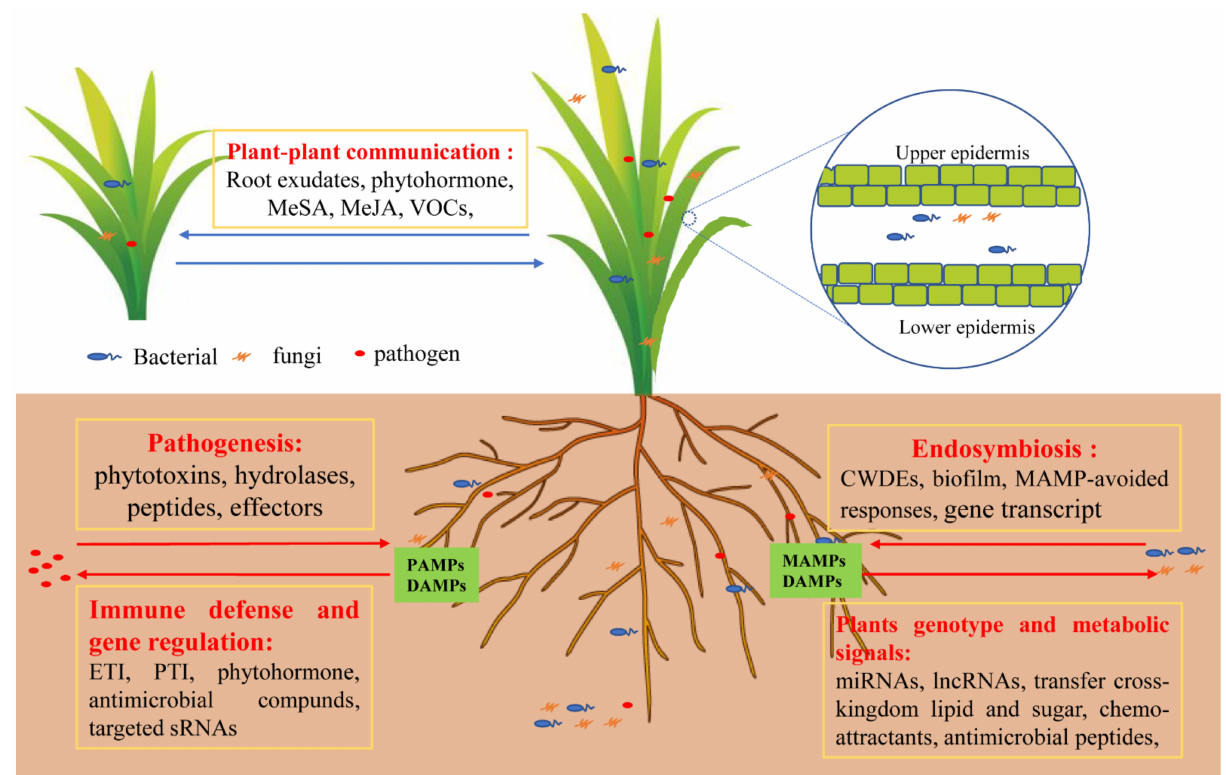
Figure 3. Immunity and symbiotic regulation of plants to microorganisms. Pathogens secrete phytotoxins, hydrolases, peptides, and other effectors. Plants activate the immune defense signaling response, such as ETI and PTI, and secrete phytohormones, antimicrobial compounds, or target sRNAs via gene regulation. Certain types of bacteria and fungi termed endophytes are allowed to enter plant cells by secreting biofilm or by using hyphae to attach to plant tissues and secrete CWDEs to degrade plant cell walls. Moreover, it can regulate gene transcription through evolution to escape plant immune signals and produce symbiotic signals as well as collectively resist pathogen attacks. Accordingly, plants secrete chemo-attractants to attract beneficial endosymbiotic microbes, evolve their own genotype, and transfer cross- kingdom lipid and sugar to endophytes, providing a good parasitic environment for endophytes. Hence, a plant’s genotype can influence the microbiome composition and shape their microbiome to enhance defense and mitigate the trade-off between growth and defense against pathogens. Abbreviations: cell wall degradative enzymes (CWDEs), methylsalicylic acid (MeSA), methyljasmonic acid (MeJA), ectomycorrhizae (ECM), microbe- or pathogen-associated molecular patterns (MAMPs or PAMPs), damage-associated molecular patterns (DAMPs), pattern-triggered immunity (PTI), effector-triggered immunity